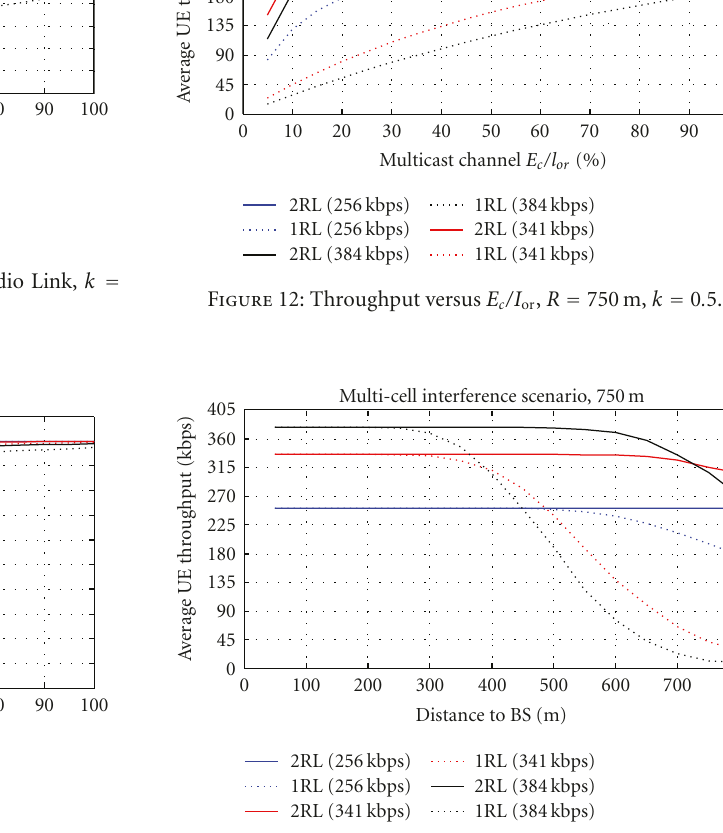
Figure 11: Average coverage (%) versus E c /I or , 2 Radio Links, k = 0 . 5.